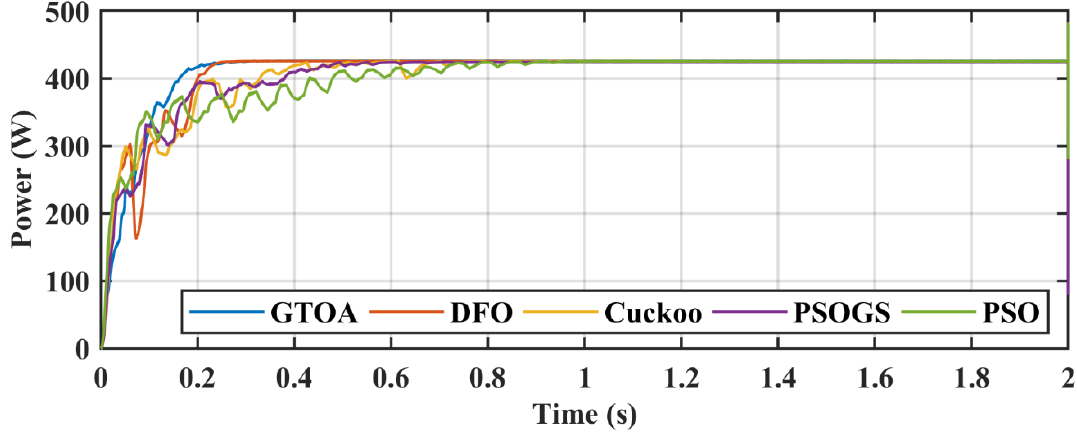
Figure 15. Comparison of power of GTOA. Electronics 2020 , 9 , x FOR PEER REVIEW